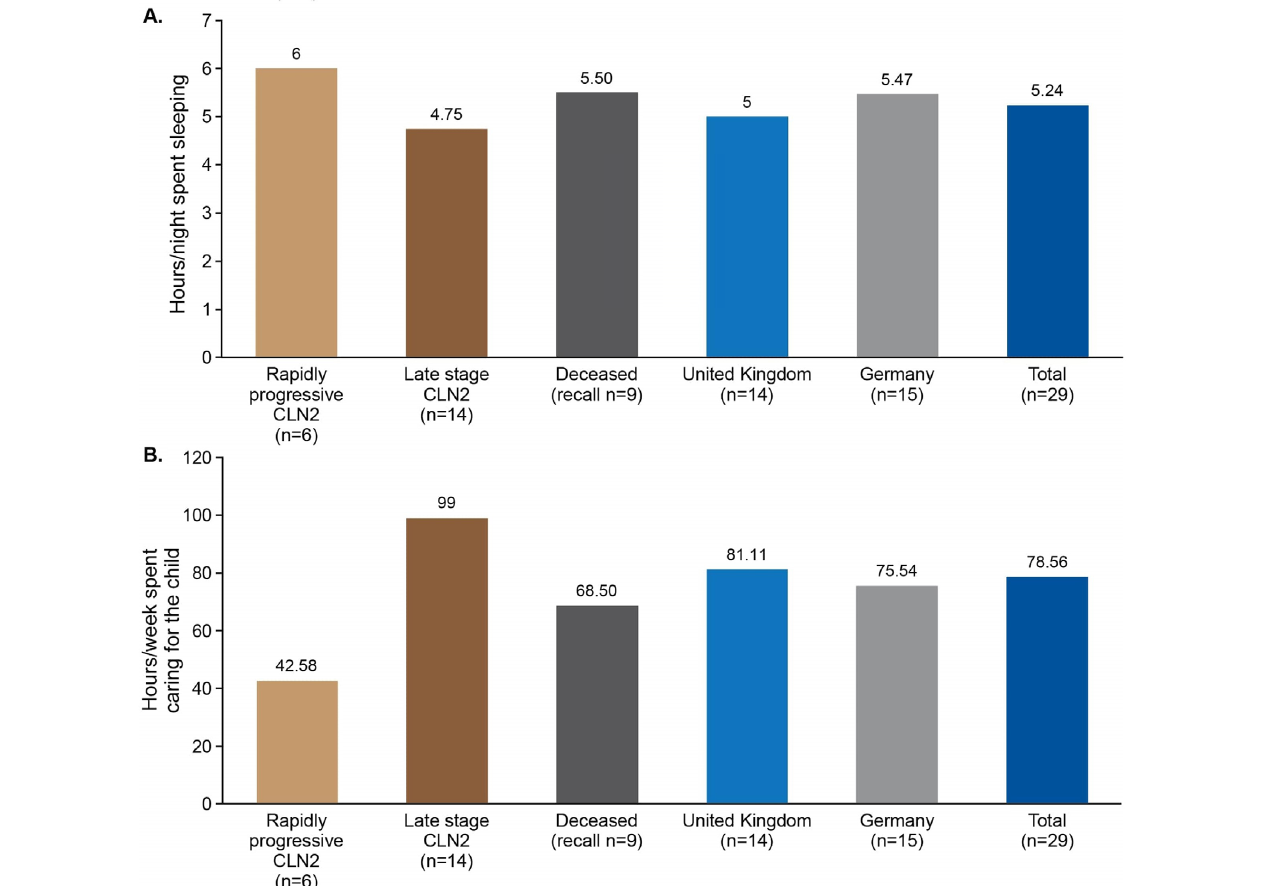
Figure 3. Impact of caring for a child with CLN2 disease on hours spent (A) sleeping (excludes adult siblings) and (B) caring for the child (excludes adult siblings). CLN2, neuronal ceroid lipofuscinosis type 2.